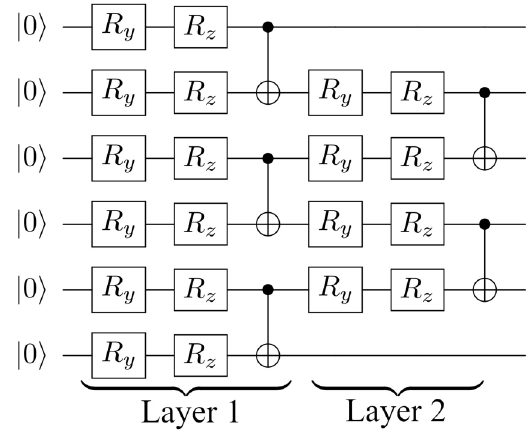
FIG. 3. The 2-depth RyRz ansatz that is used for VQE calcu- lations using model Ising Hamiltonians.